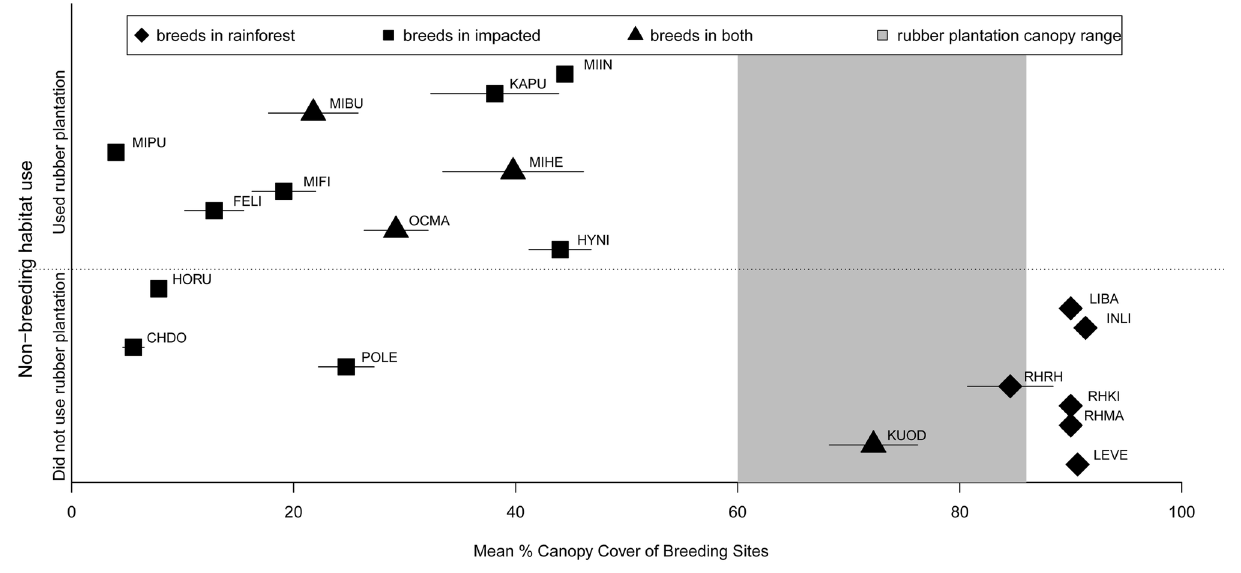
Figure 4. Integrated breeding and non-breeding habitat preferences. Symbols indicate the mean percent canopy cover (± SE) of breeding sites used by each species according to their preferred breeding habitat (rainforest, impacted or both rainforest and impacted). Species in the top panel used the rubber plantation as non-breeding habitat, and species in the bottom panel did not. Species codes next to each symbol are the same as in Figure